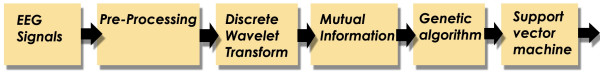
The overall structure of the proposed method.